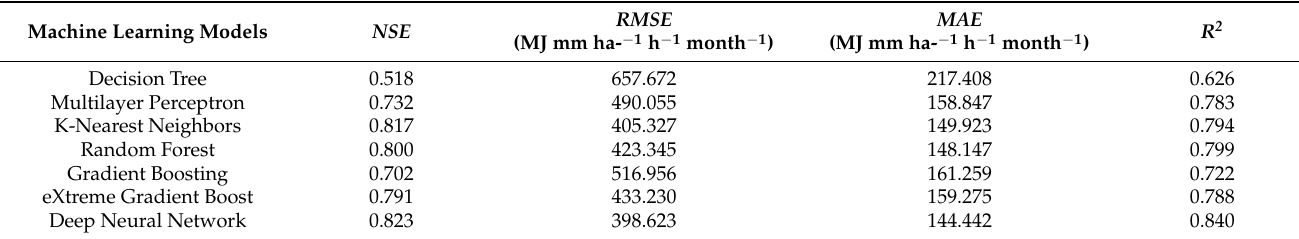
Table 5. Prediction accuracy results of seven machine learning models. Machine Learning